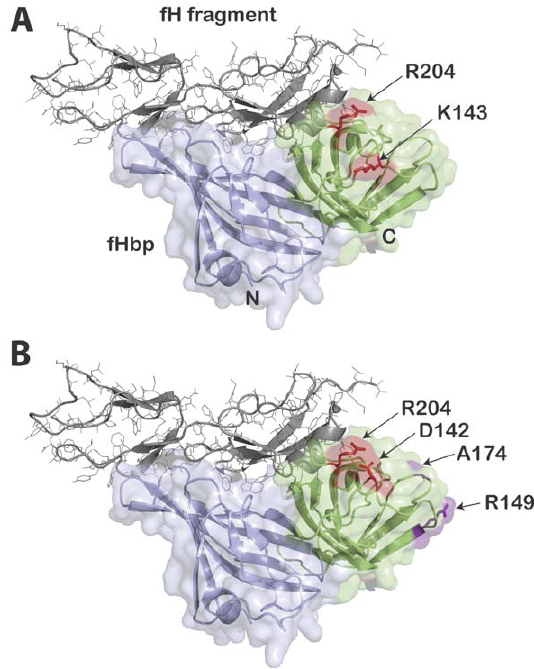
Figure 6. Structural model of fH-fHbp complex. fH fragment is shown in gray. The amino-terminal domain of fHbp is shown in light blue, while the carboxy-terminal domain is shown in light green. Panel A. Alanine substitutions for arginine at residue 204 (R204A) or for lysine at position 143 (K143A) decreased or eliminated JAR 1 binding. His substitution for Arg at position 204 (R204H) did not affect JAR 1 binding (See Figure 5). Panel B. Residues shown previously by NMR to be part of the mAb502 binding site [29]. In addition, we found that alanine or histidine substitutions for arginine at residue 204 (R204A or R204H) eliminated binding of mAb502, and an alanine substitution for aspartic acid at residue 142 (D142A) decreased binding (See Figure 3). The figure was constructed with PyMol (http://www.pymol.org).